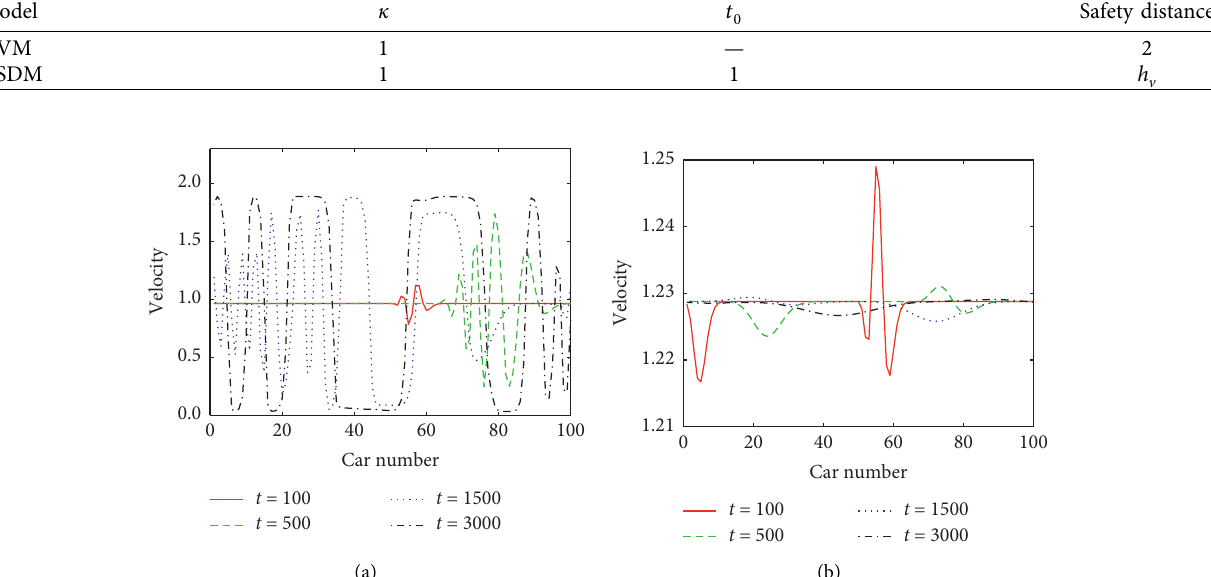
Table 2: Parameters of the numerical simulation experiment when κ is constant. Model